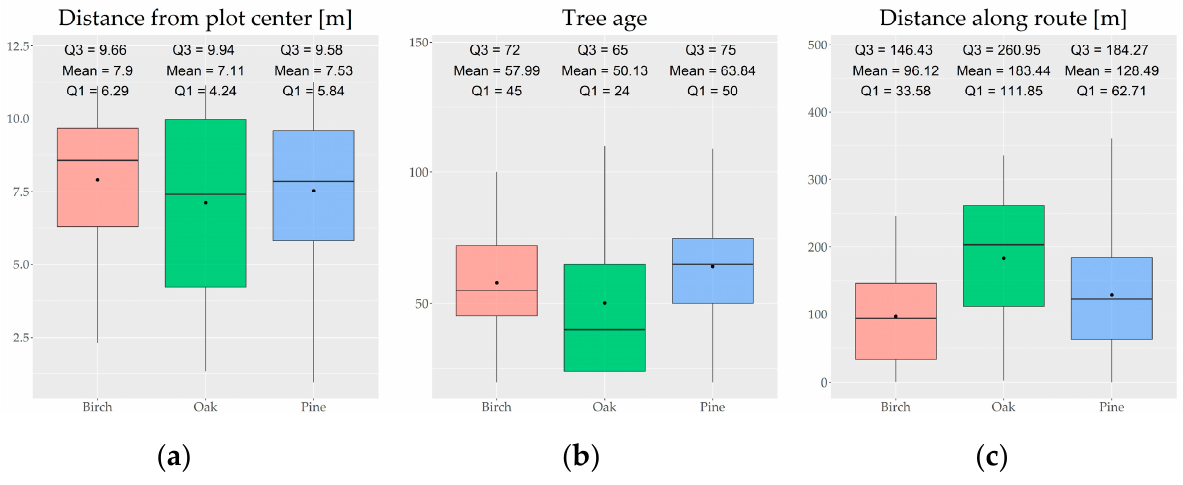
Figure 8. The boxplots for three groups of species containing: ( a ) the distance of the single tree from the sample plot center, which was also the start point of the scanning route; ( b ) the age of all trees within the species group; and ( c ) the distance on the scanning route for every analyzed tree, where a 0 value means the start of the scan.